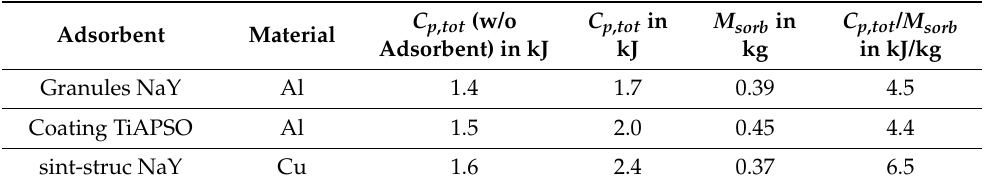
Table 10. Thermal masses, adsorbent mass, and ratio of thermal mass and adsorbent mass of three different shapes of the